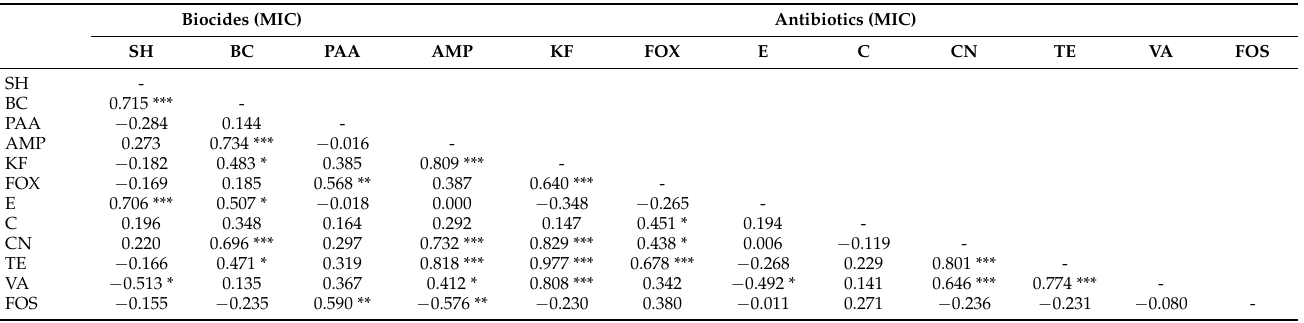
Table 4. Coefficients of correlation between the MIC values of 12 biocides and antibiotics in eight strains of Listeria monocytogenes .